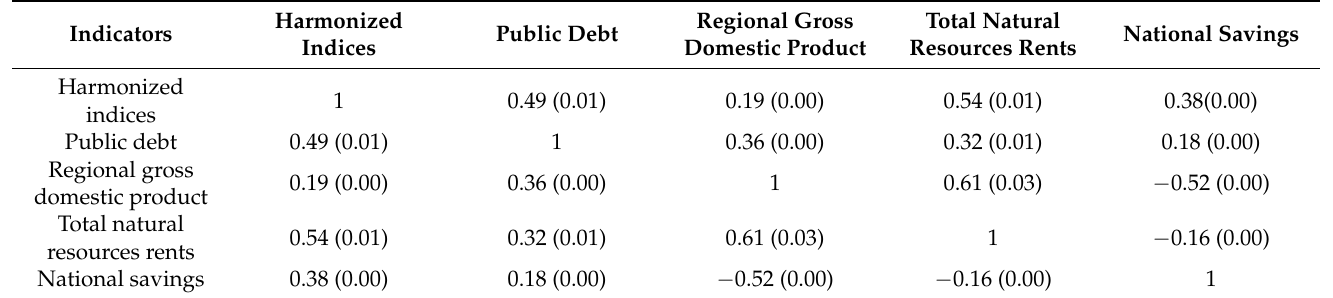
Table A3. Correlation matrix between all initial indicators for macroeconomic stability.